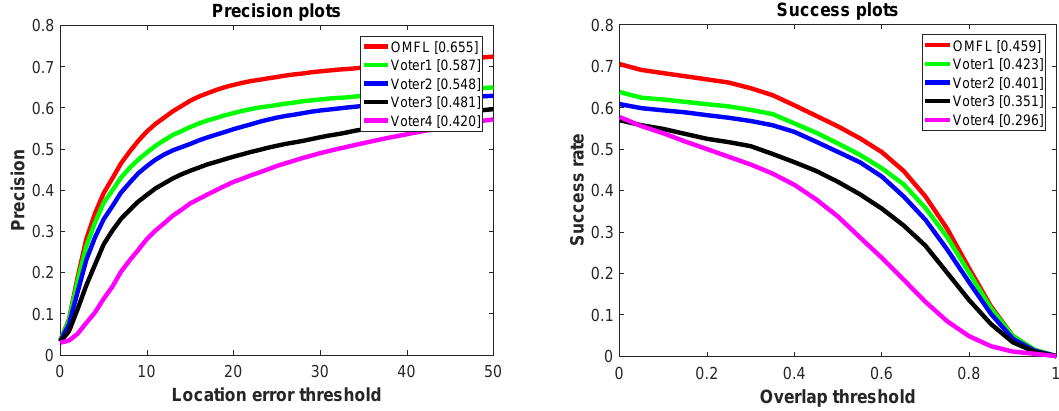
Figure 9. Comparisons between the presented OMFL tracker with different